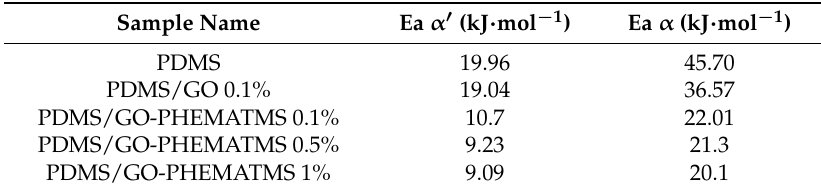
Table 1. Activation energies of glass transition process for pure PDMS and various PDMS composites. Filler content is in vol